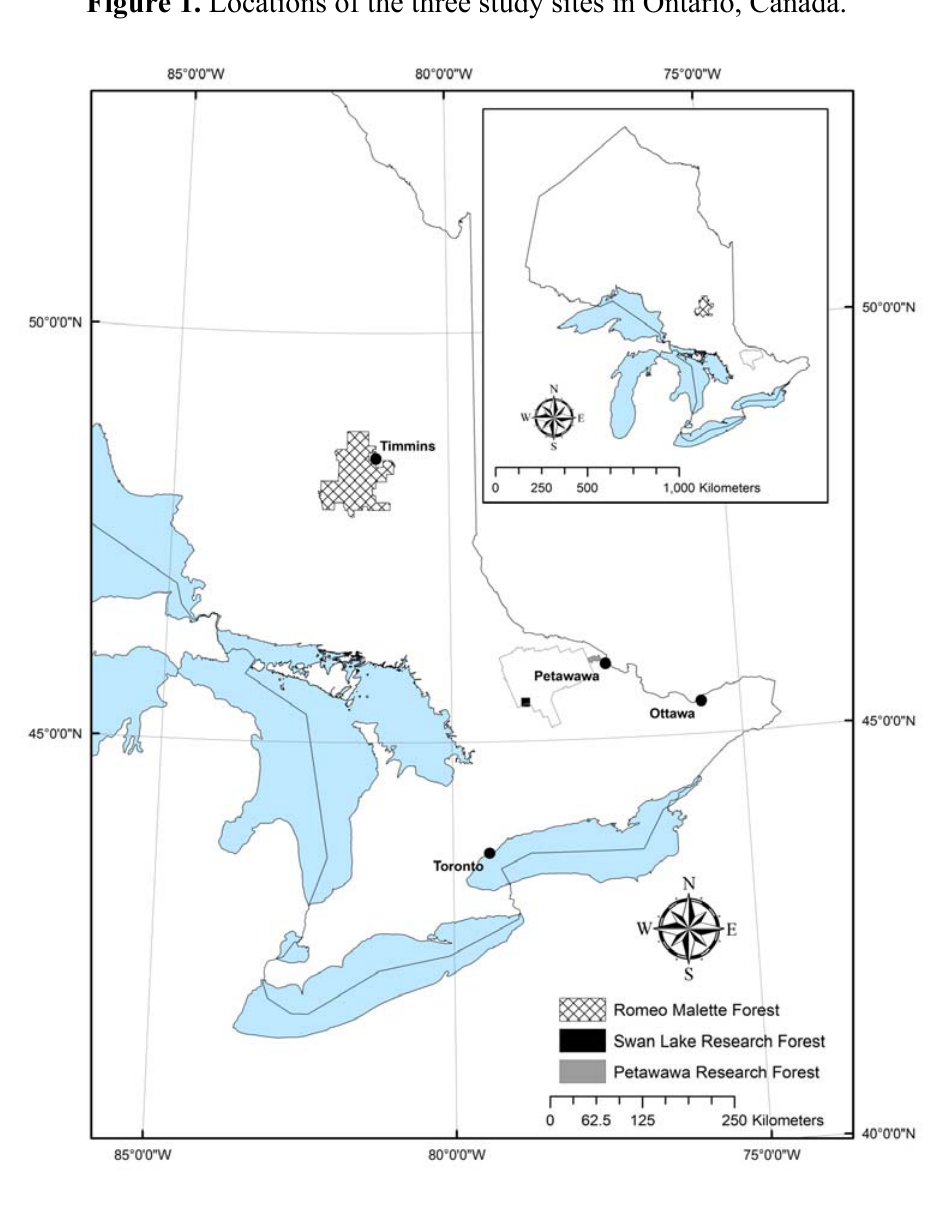
Figure 1. Locations of the three study sites in Ontario,